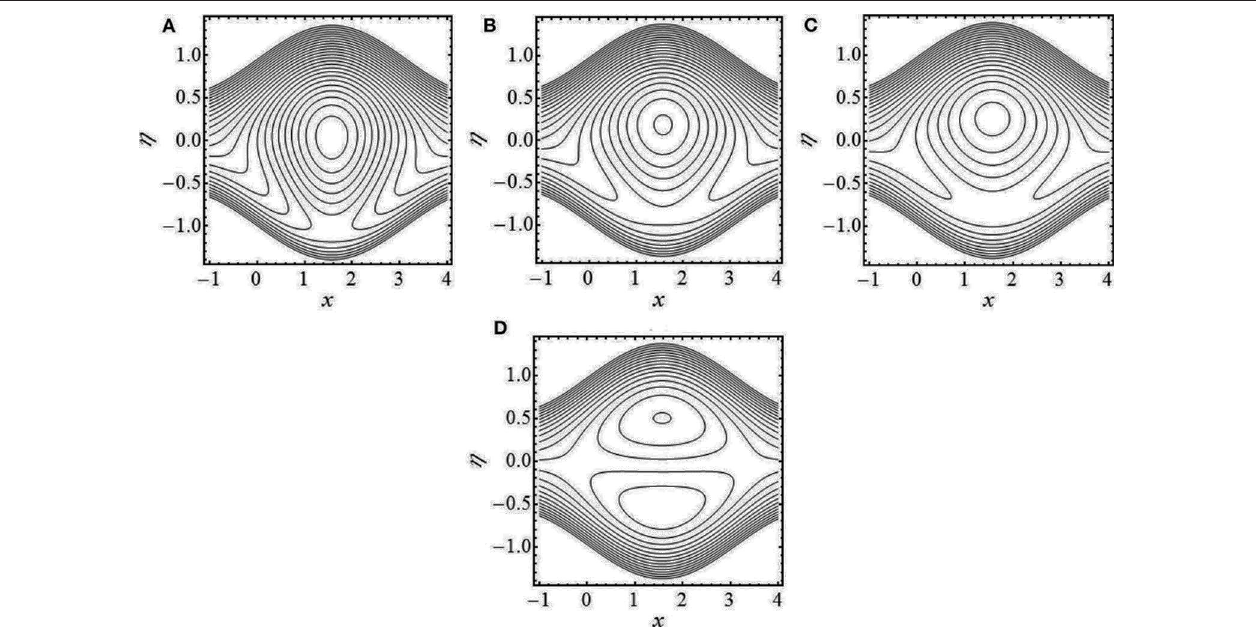
FIGURE 9 | Streamlines in wave frame for (A) γ = 2, (B) γ = 2.5, (C) γ = 3, and (D) γ → ∞ . The other parameters chosen are N 1 = 0.5, N 2 = 1.2, and λ = 0.8.